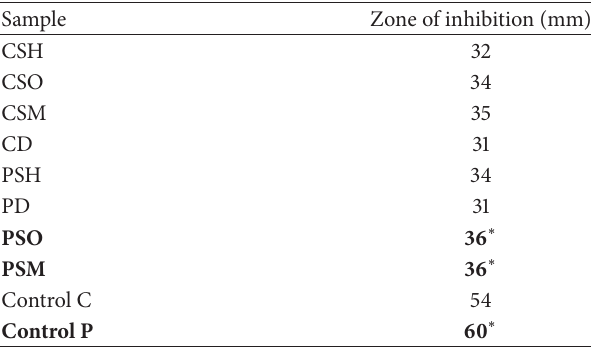
Figure 5: Antibacterial activity of the synthesized silver nanoparti- cles fabricated onto perspiration pads. Table 2: Zone of inhibition of synthesized silver nanoparticles against Corynebacterium